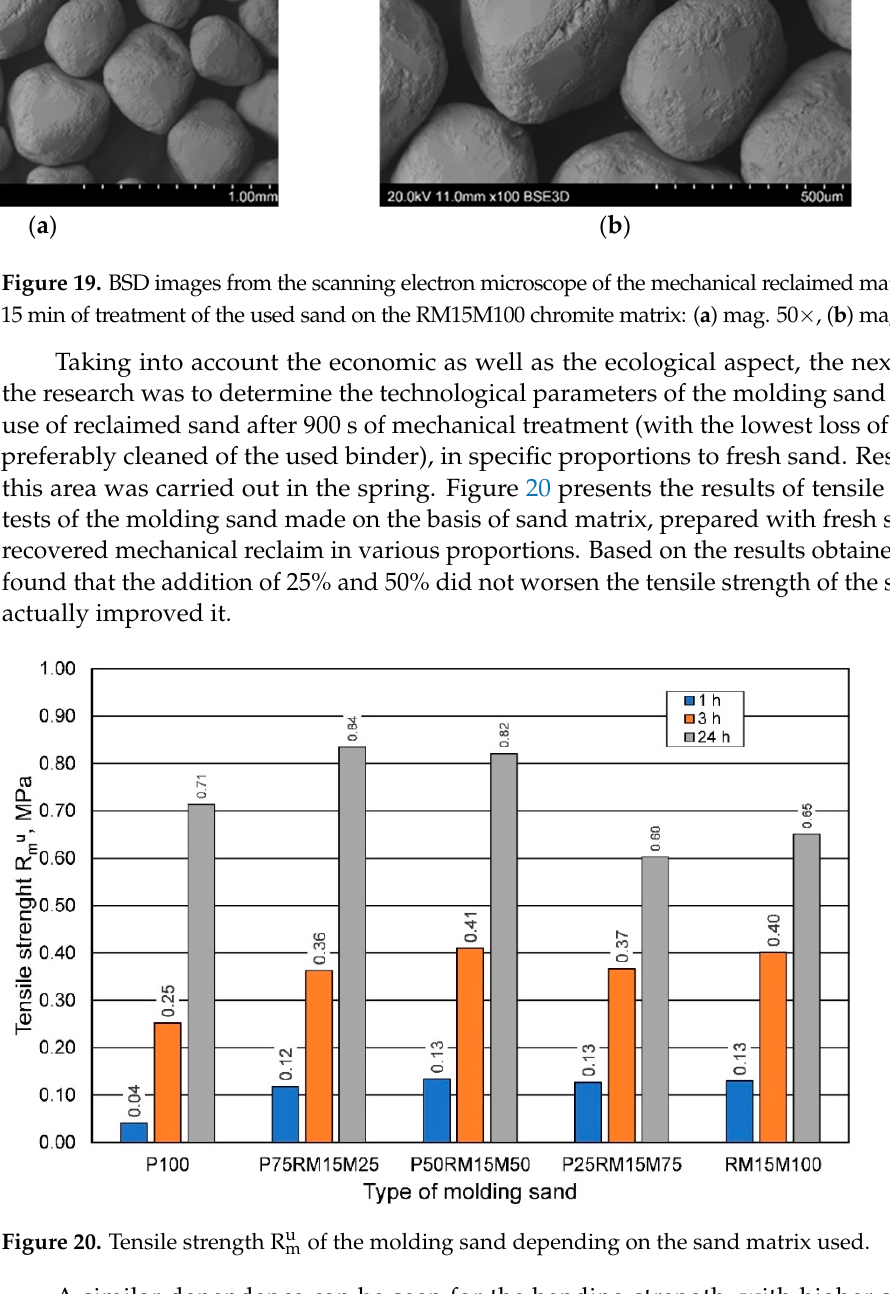
Figure 18. BSD images from the scanning electron microscope of mechanical reclaimed material after 15 min of treatment of the used sand on the RM10M100 chromite matrix: ( a ) mag. 50×, ( b ) mag. 100×.